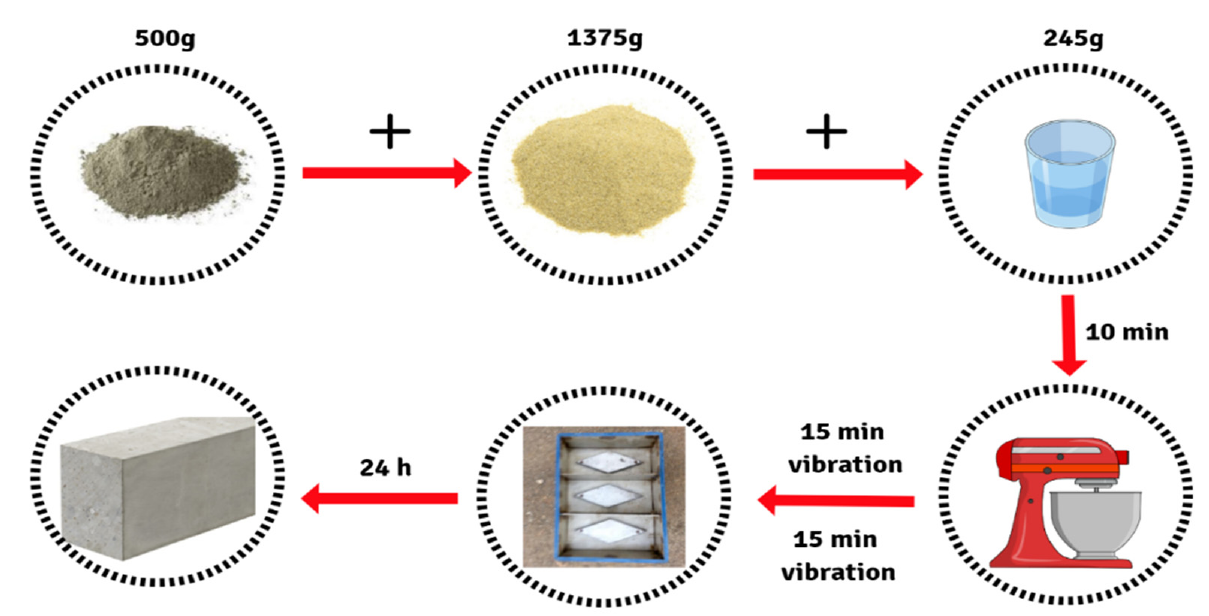
Figure 1. An illustration of the preparation materials and steps used for OPC preparation, which include: OPC, sand, water, mixing machine, steel moulds and prepared OPC samples, respectively.